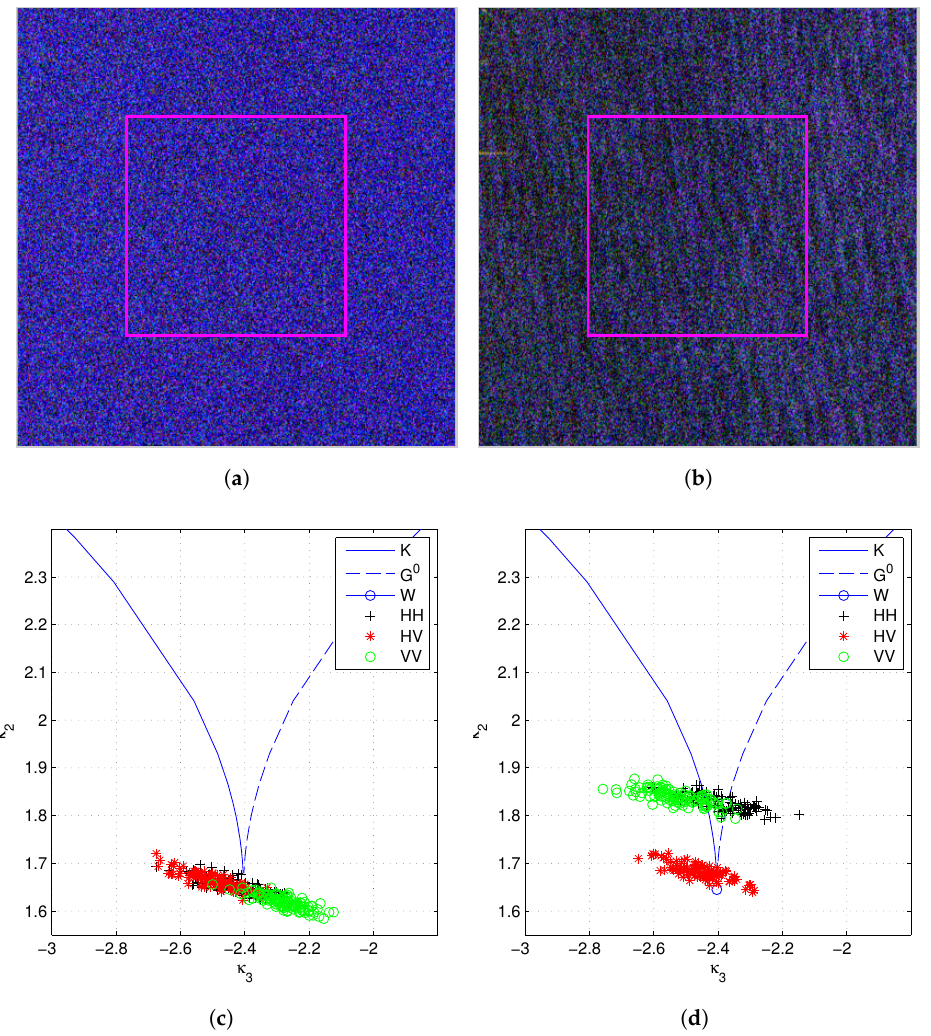
Figure 7. Scalar log-cumulants of different polarimetric channels (the HH, the HV and the VV channels) over sea areas. ( a ) Test region over smooth sea surface. ( b ) Test region over sea surface with waves. ( c ) Log-cumulants of the smooth sea surface. ( d ) Log-cumulants of the sea surface with